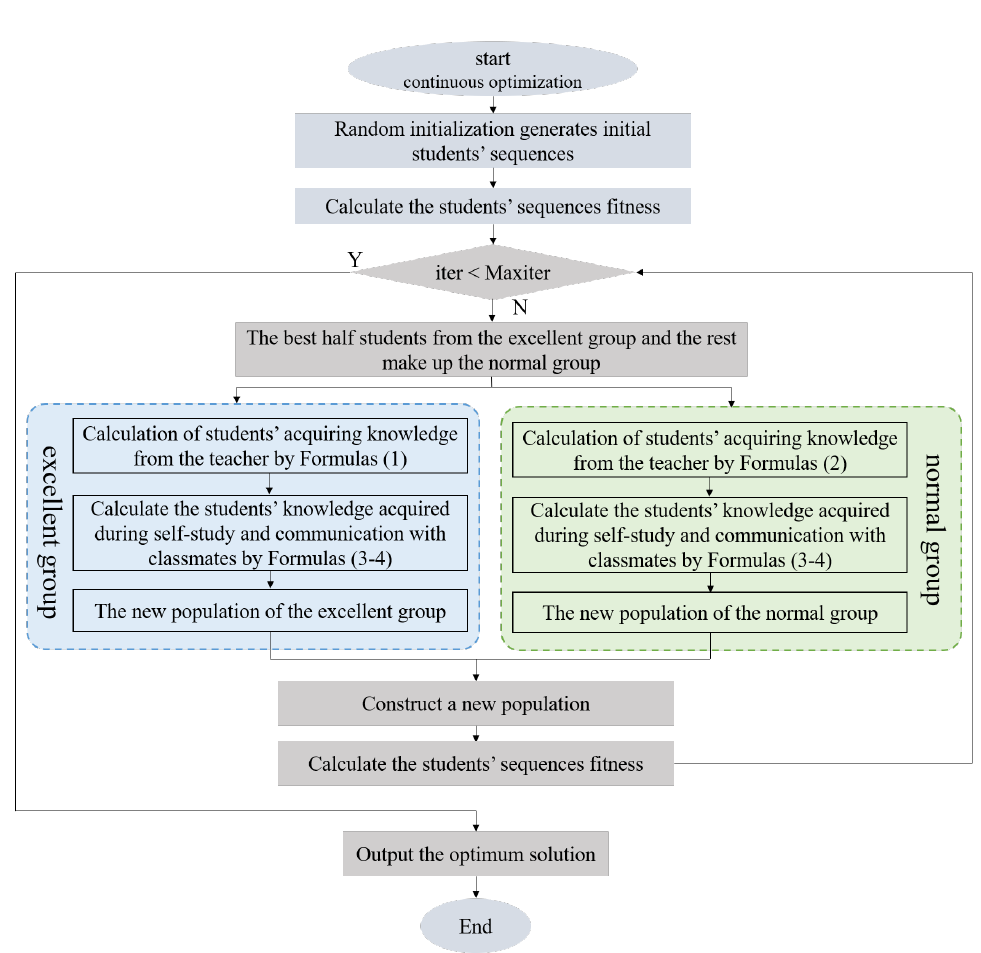
Figure 2. Flowchart of group teaching optimization